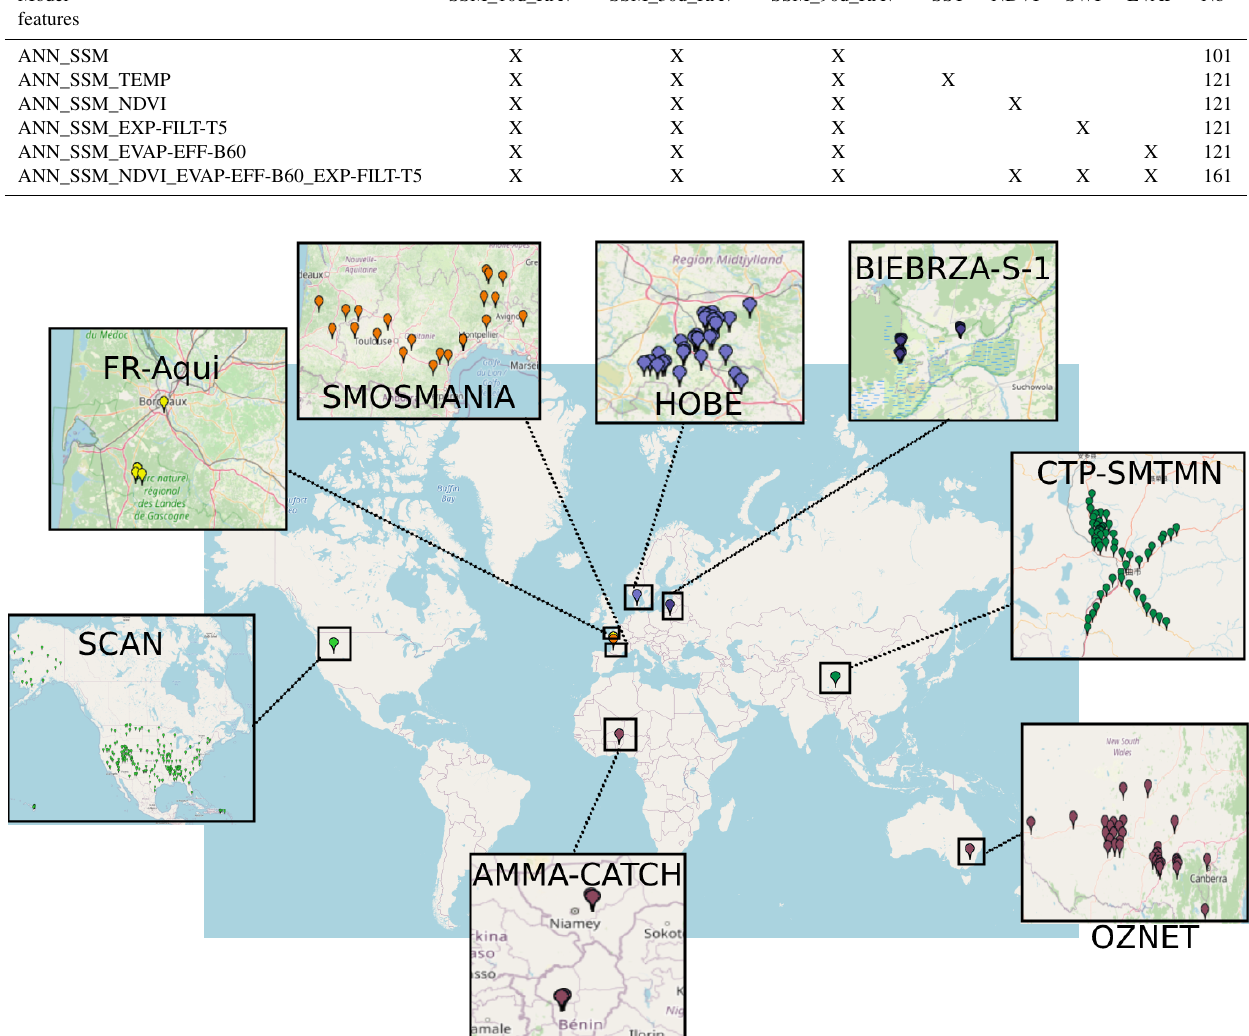
Figure 2. International Soil Moisture Network (ISMN) network distribution (adapted from the ISMN web data portal: https://www.geo. tuwien.ac.at/insitu/data_viewer/, last access: 7 April 2022; scale: 1cm =